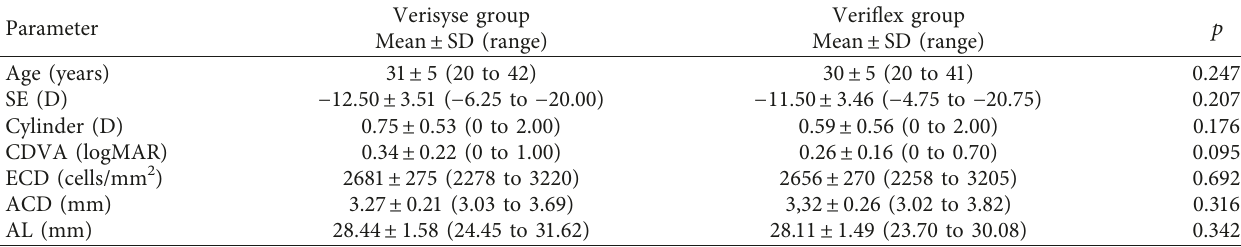
Table 1: Preoperative characteristics.